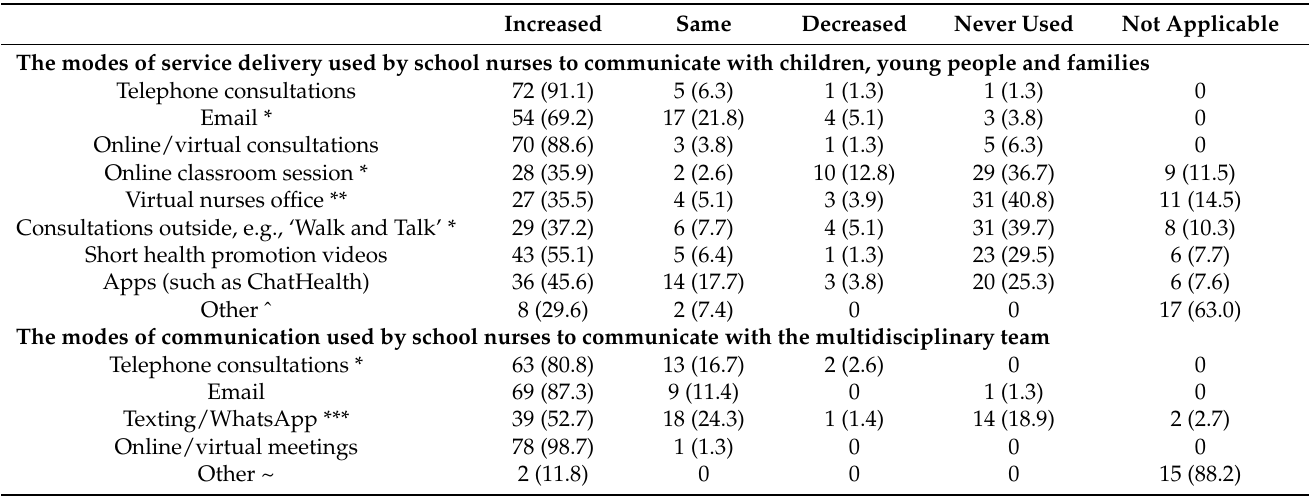
Table 3. The modes of service delivery used by school nurses to communicate with children, young people and families and the multidisciplinary team during the COVID-19 pandemic (reported as frequency and percentage).